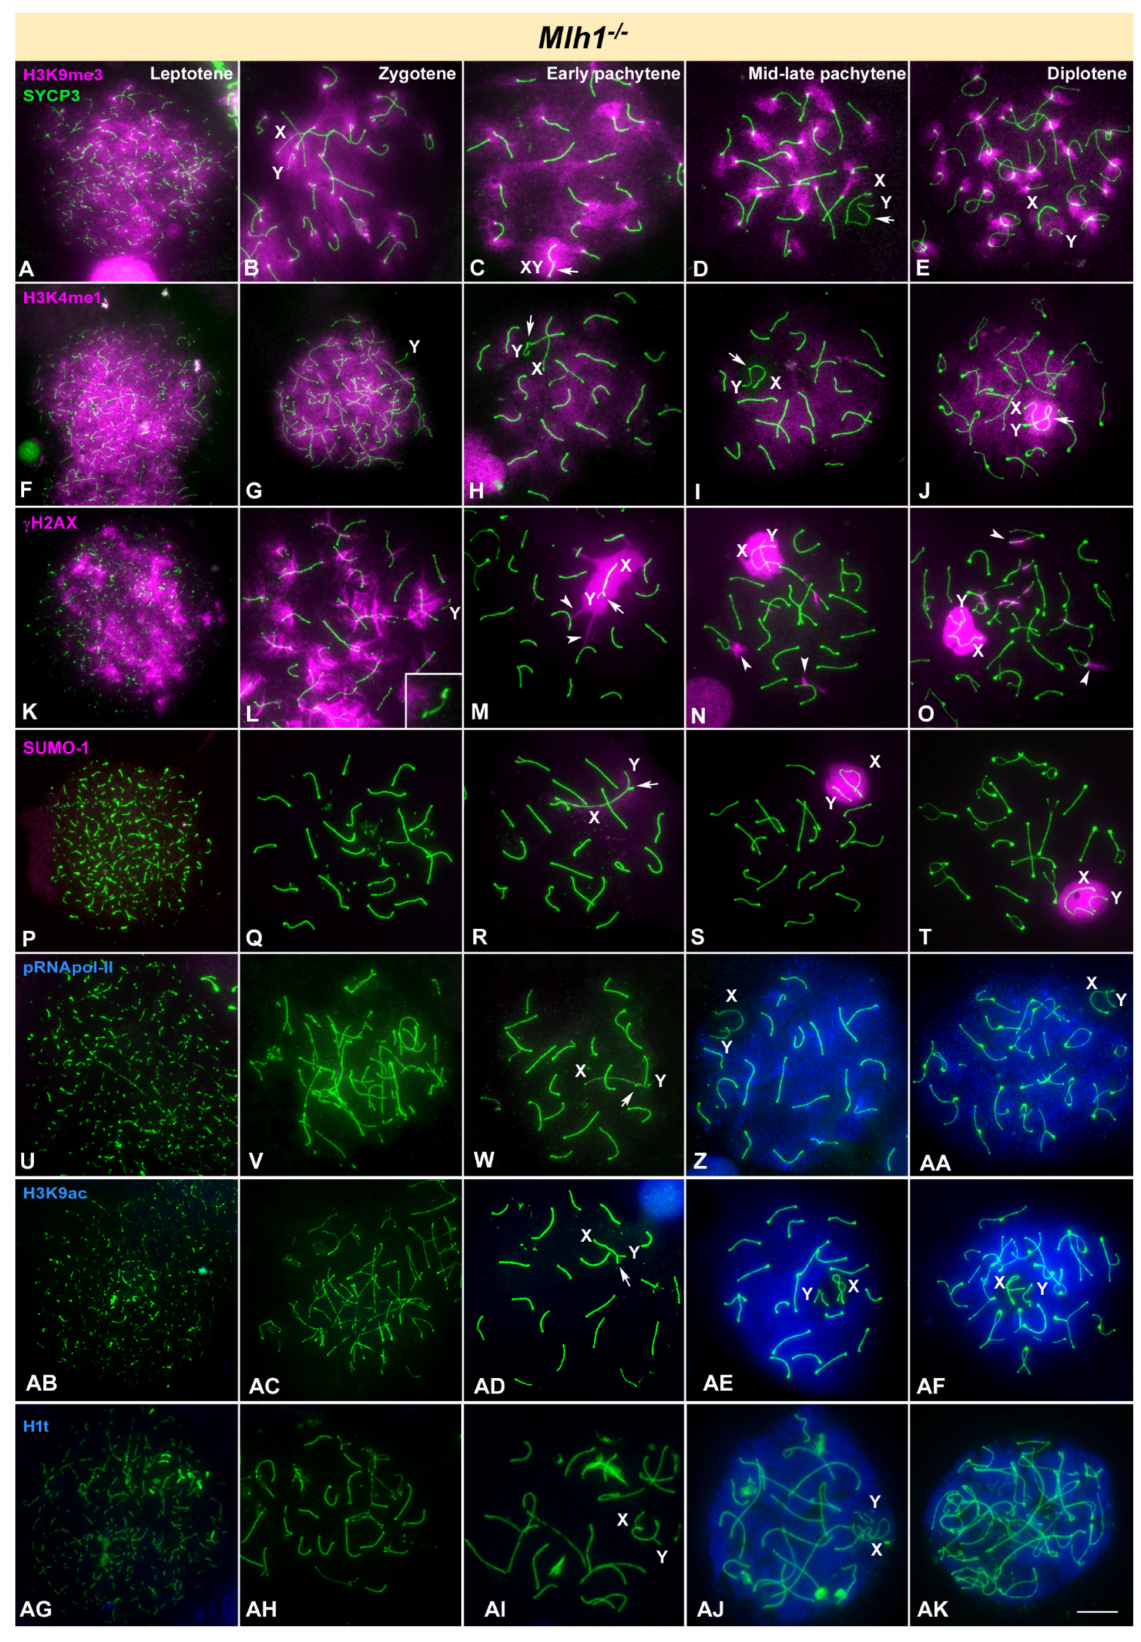
Figure 2. Immunolocalization of SYCP3 (green) and epigenetic markers of silencing (pink) or transcription activation (blue) in Mlh1 knockout mice. X, Y indicate sex chromosomes. Arrow indicates the synapsed region of sex chromosomes. ( A – E